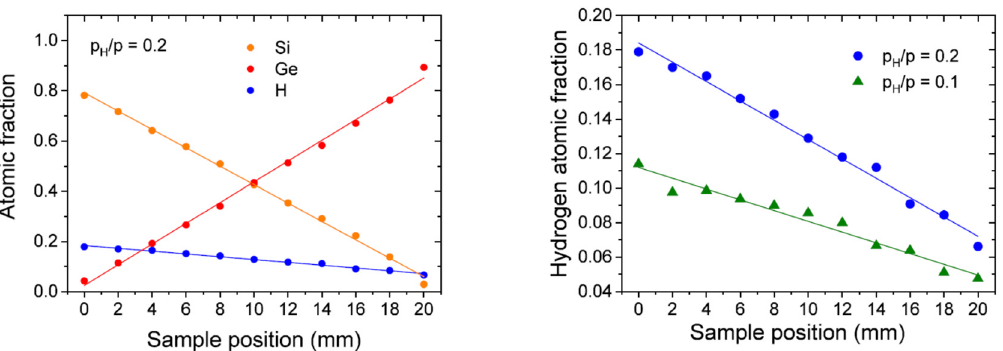
Figure 12. ( Left ): atomic ratios of Si, Ge, and H measured by RBS in a-SiGe:H layer along 20 mm. ( Right ): H atomic fractions of samples sputtered in p H /p = 0.1 and 0.2 H partial pressure measured by ERDA. The solid line is a linear fit of the measured values. Reproduced with permission from [60]. Copyright © 2020, Springer